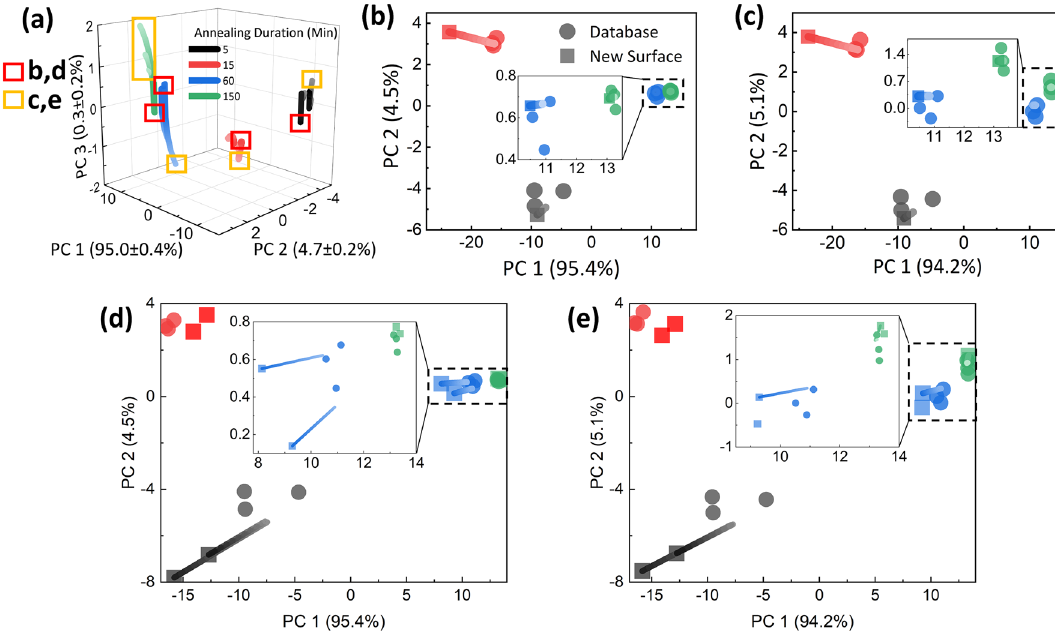
Figure 6. ( a ) 3-D plot of PCA database of SEM images over increasing surface fitting deviation scaling. Darker to brighter color denotes the increase in deviation scaling, from 1 to 26. The first three dominant principal components account for 100% of the PCA variance in average. ( b , c ) The projection and error minimization of synthetic experimental SEM images, respectively for unscaled ( b ) and scaled ( c ) database. Each figure demonstrate the iterative clustering on non-scaled and scaled databases, respectively. Circles represent the database, and squares the new surfaces. The lines illustrate the iterative classification for each new surfaces. Error is minimized in the direction of increasing brightness. ( d , e ) Experimental SEM images projected on PCA database, respectively for unscaled ( d ) and scaled ( e ) databases. For 5 min annealed devices, the experimental images were acquired with a different contrast setting.